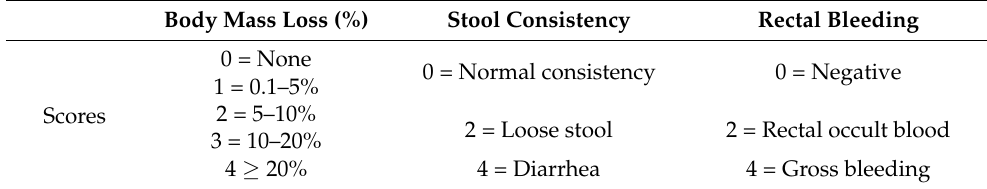
Table 1. Scoring of Disease Activity Index (DAI). Body Mass Loss (%) Stool Consistency Rectal